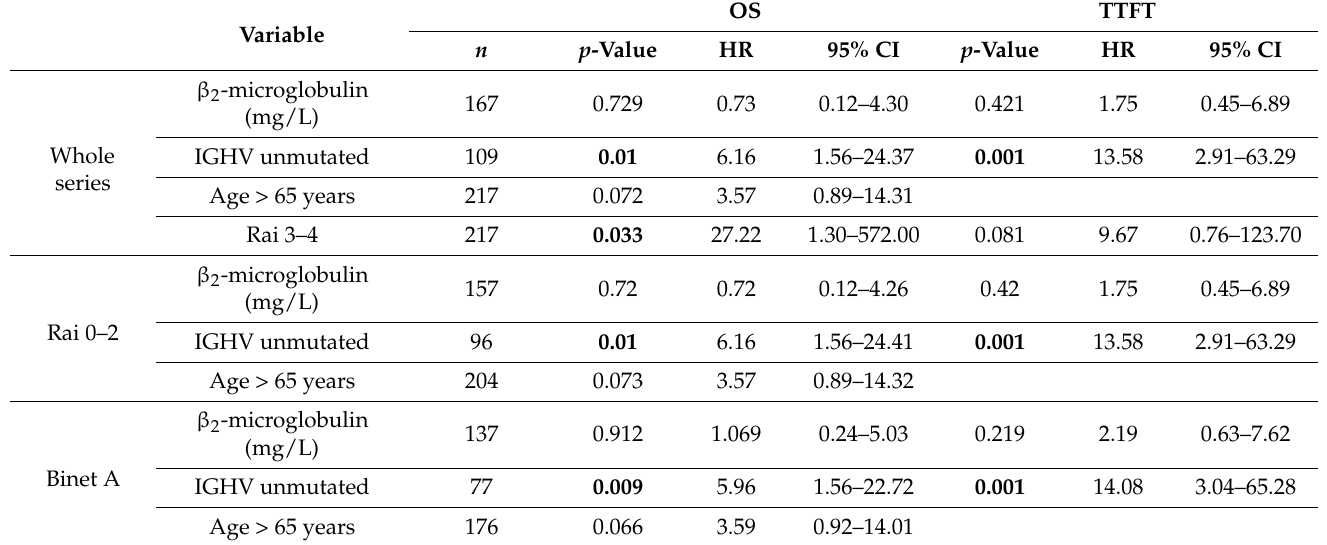
Table 1. Multivariate analysis of overall survival (OS) and time to first treatment (TTFT) for the whole series and the early stages (Rai 0–2 and Binet A). n : number of data considered. Significant values (according to the Cox regression) are shown in